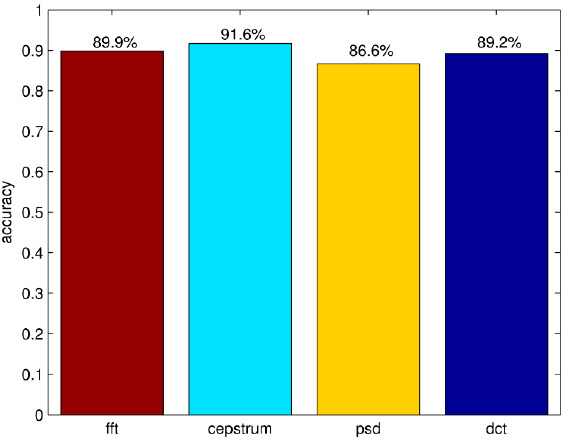
Figure 11. Correct differentiation rates of frequency domain features.